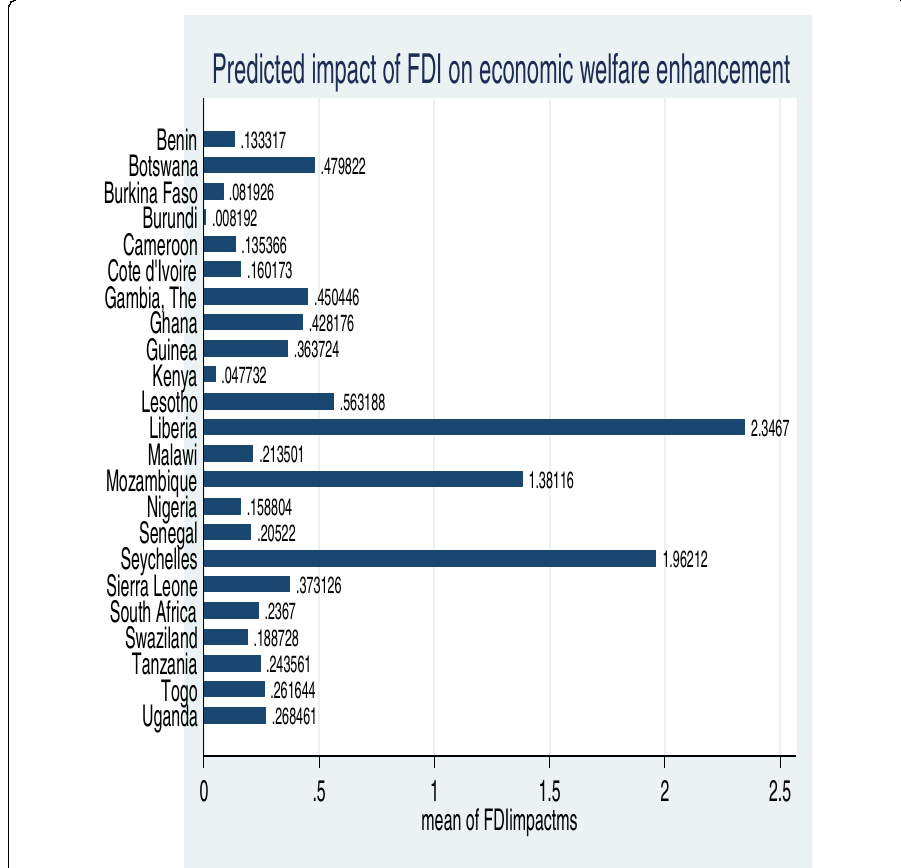
Fig. 2 Predicted (mean) impact of FDI on economic welfare at different levels of financial development (Money supply as proxy for financial